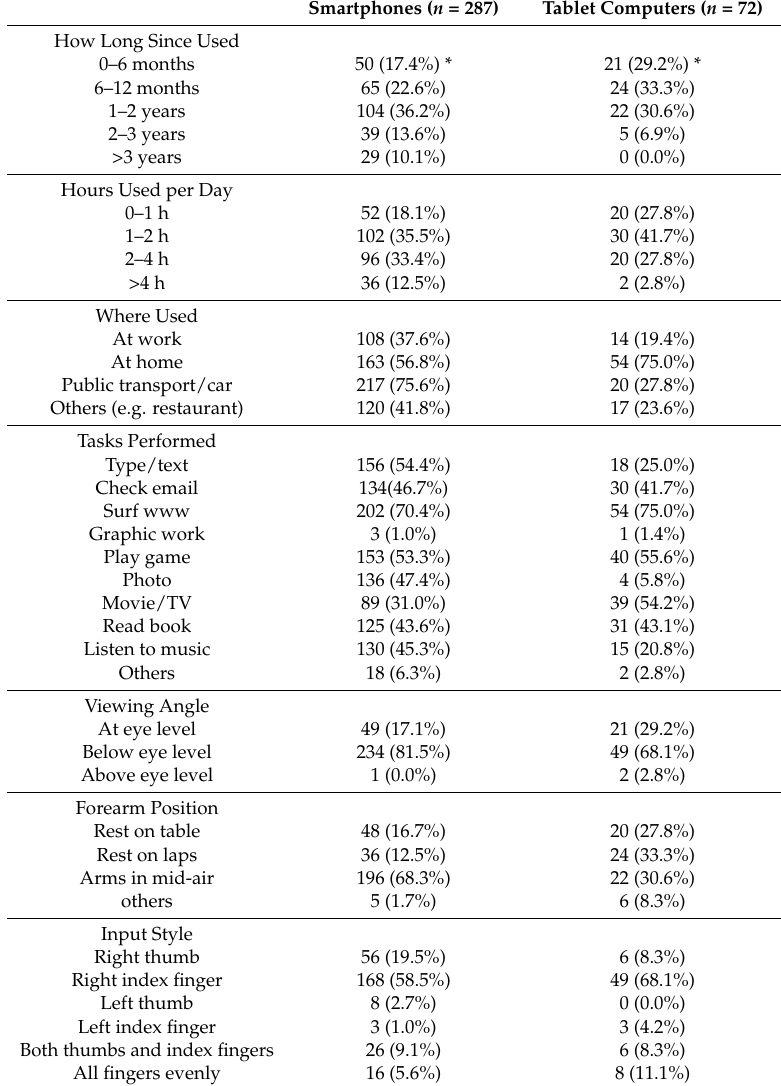
Table 3. Characteristics of touchscreen device use-duration, tasks and postural